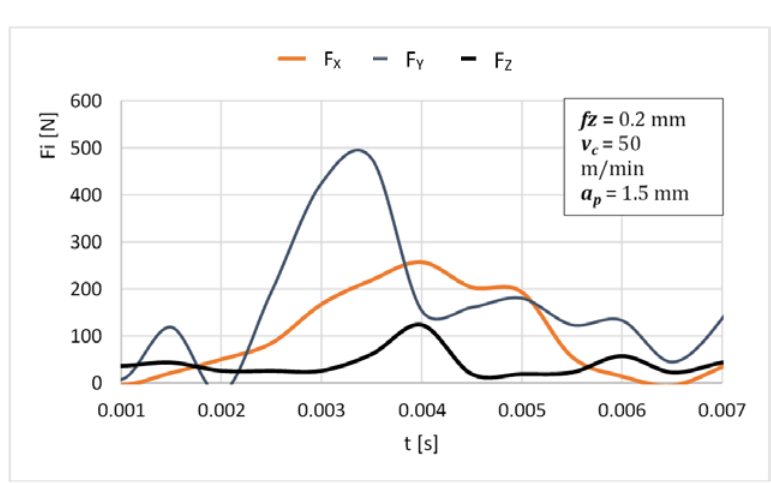
Figure 16. Actual cutting forces.